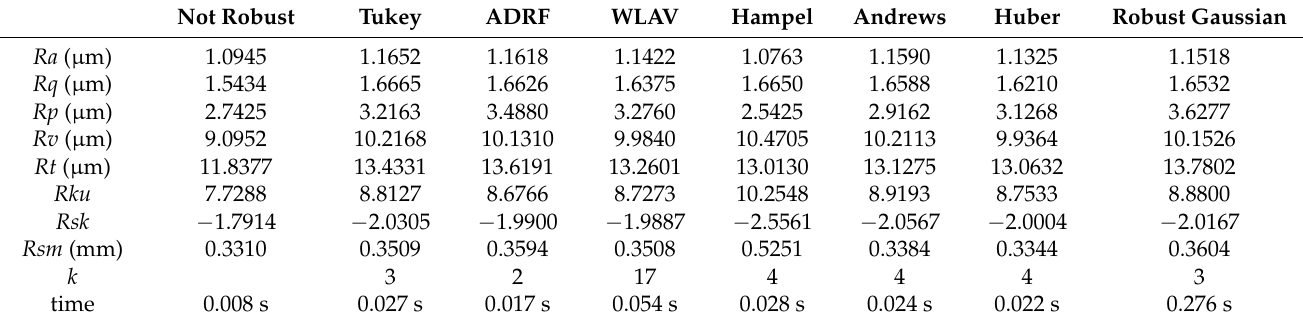
Table 6. Comparison of roughness parameter values of using different filtering